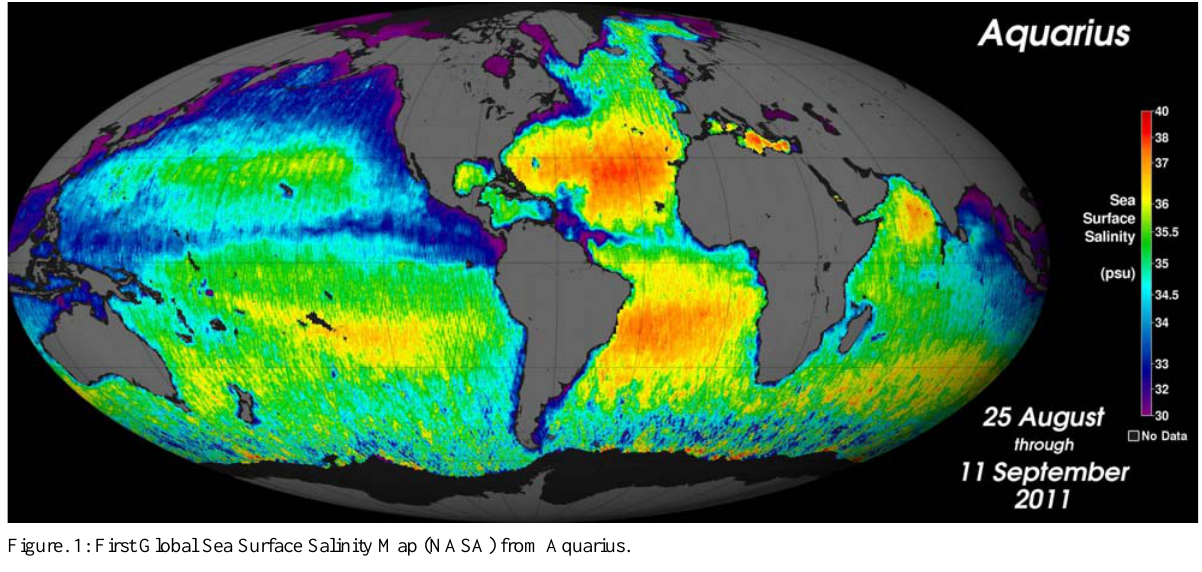
Figure. 1: First Global Sea Surface Salinity Map (NASA) from Aquarius.